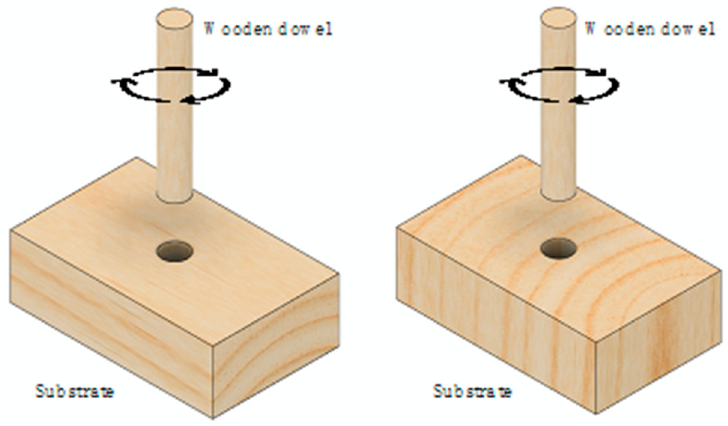
Figure 8. A dowel inserted into a wooden block in rotary welding: ( a ) perpendicular to, and ( b ) parallel with the fibre orientation of the